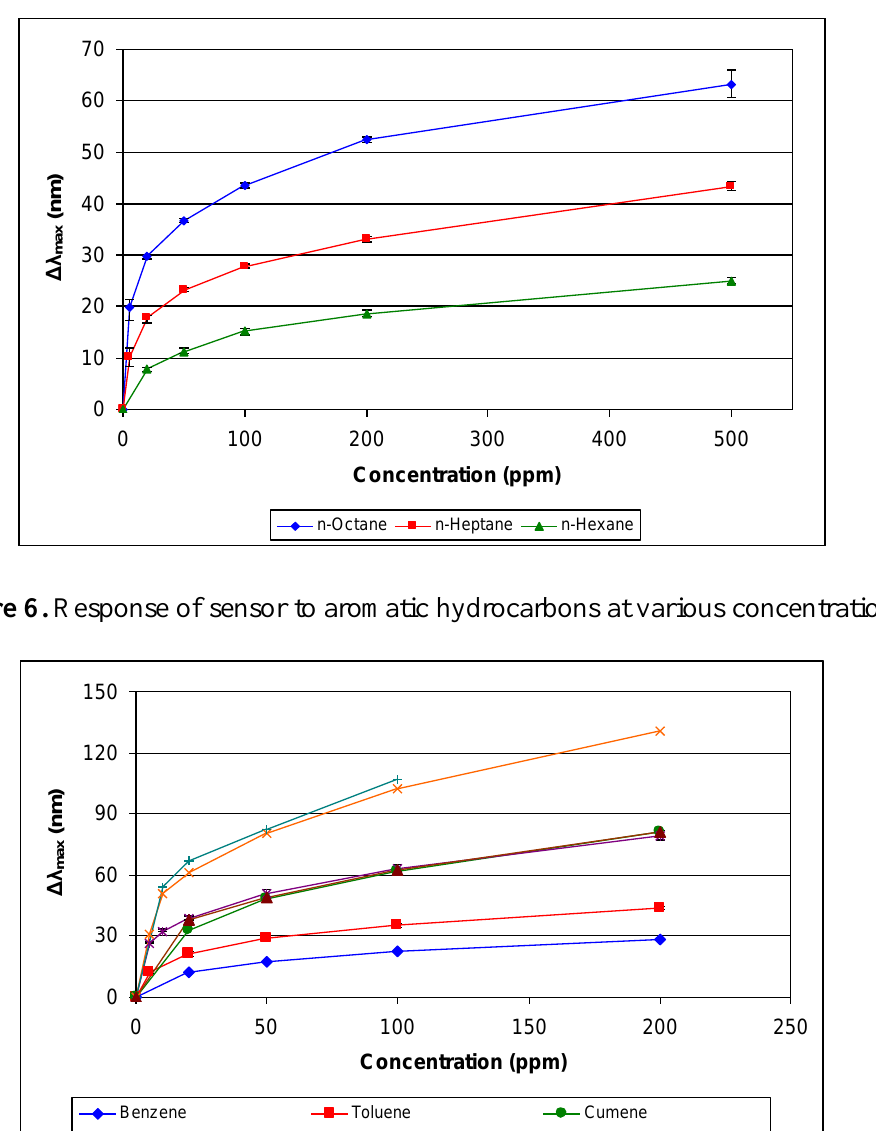
Figure 5. Response of sensor to linear hydrocarbons at various concentrations.